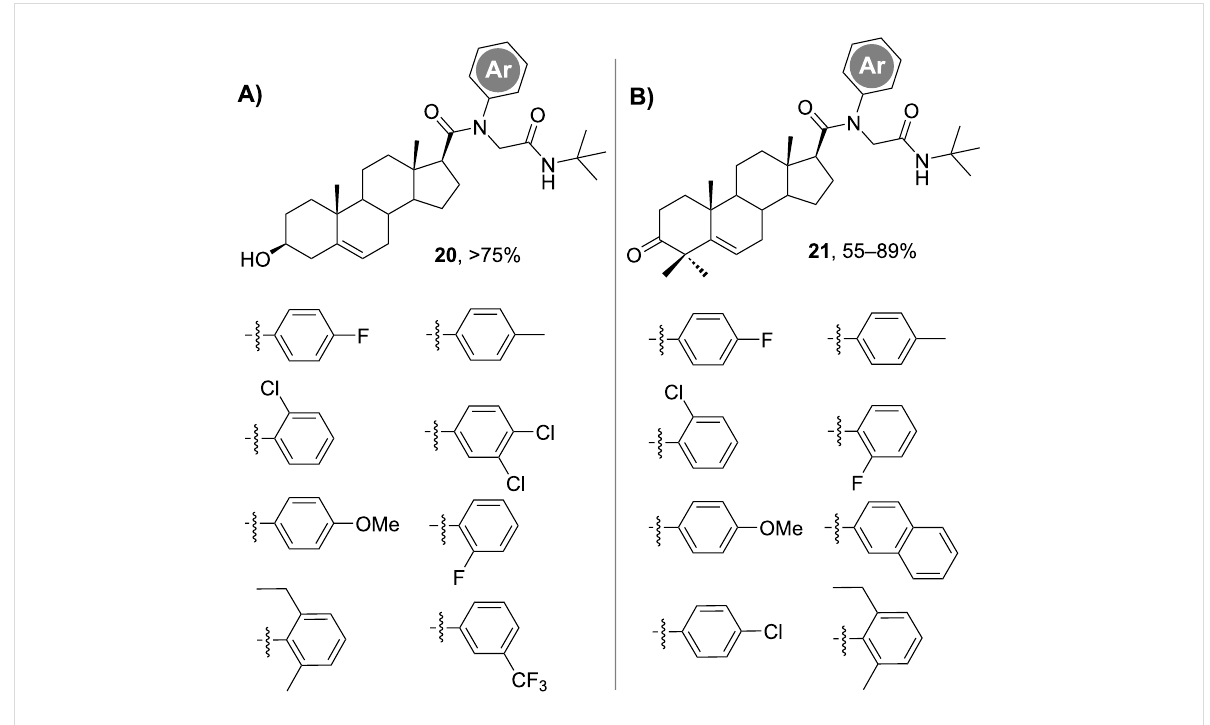
Figure 2: Ugi-4CR-derived library of androstanic azasteroids with diverse substitution patterns at the phenyl ring (amine component) [23].